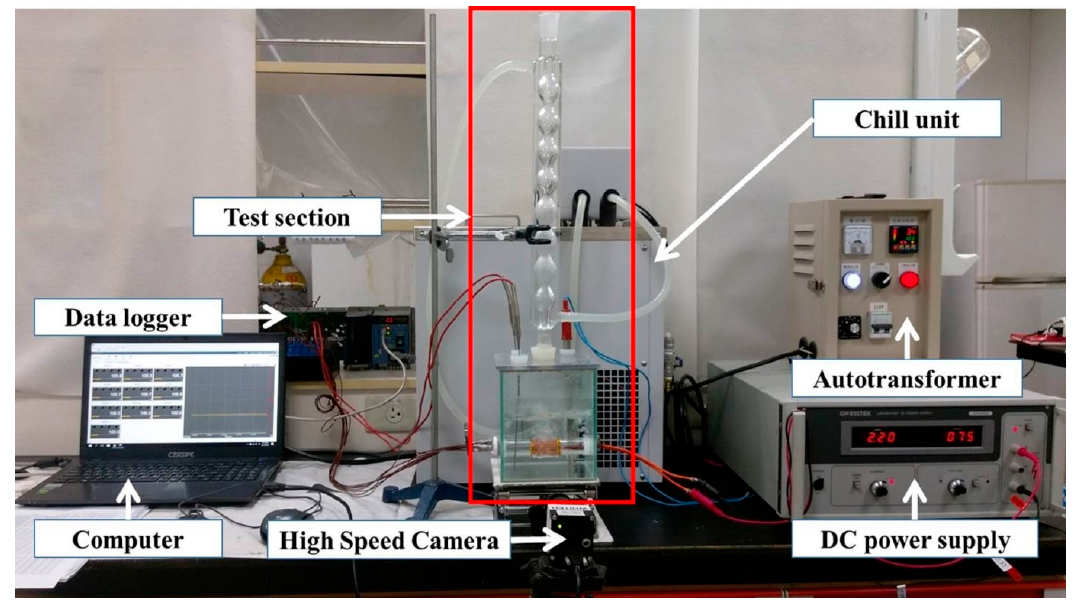
Figure 3. Annotated photograph of experimental setup.